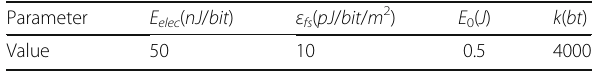
Table 1 Definitions of parameters and variables used in this article